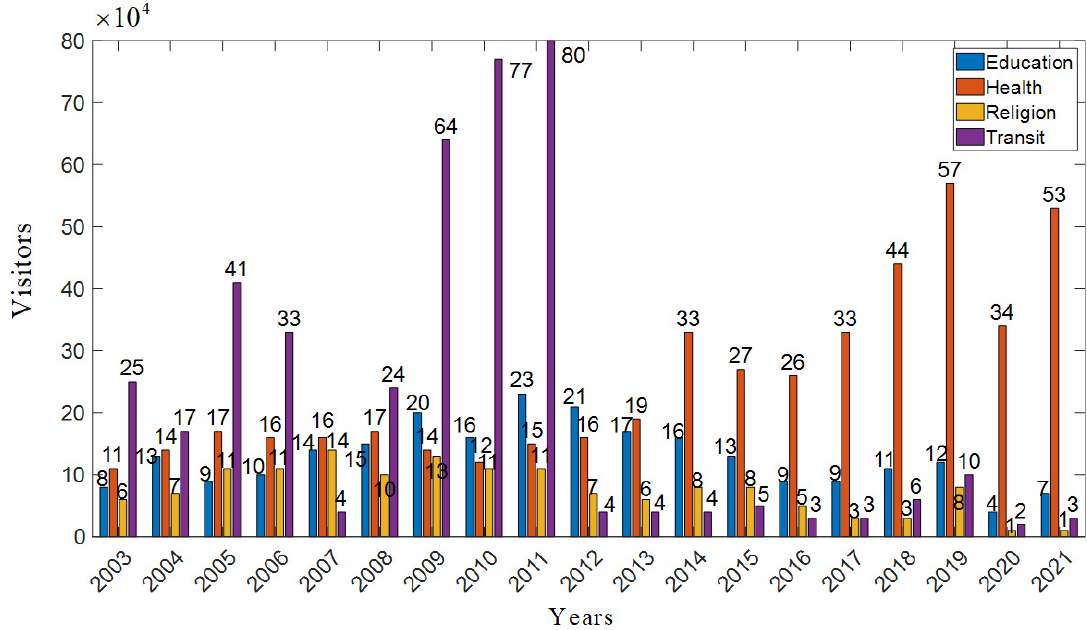
Figure 1. Departing foreign visitors for education, health, religion, and transit reasons.